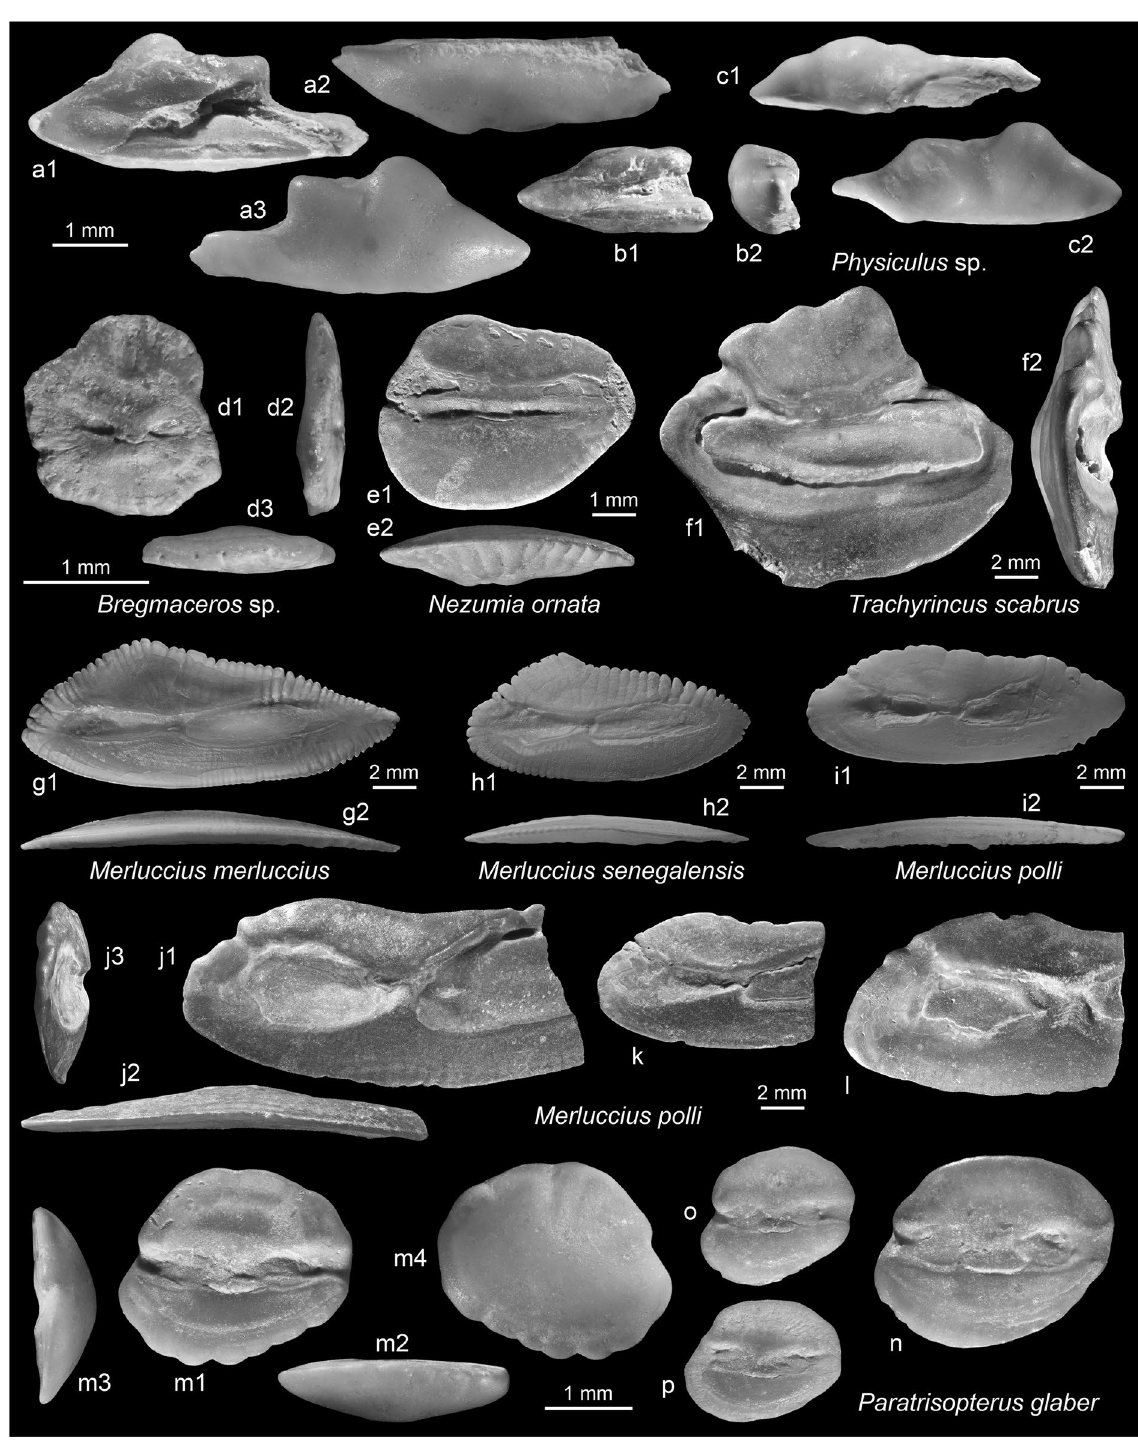
Fig. 14 Gadiformes. a – c Physiculus sp. SMF PO 101.205, Dar bel Hamri. d , Bregmaceros sp. SMF PO 101.206, Dar bel Hamri. e , Nezumia ornata (Bassoli, 1906), SMF PO 101.207 (reversed), Dar bel Hamri. f , Trachyrincus scabrus (Rafinesque, 1810), SMF PO 101.275, Dar bel Hamri. g , Merluccius merluccius (Linnaeus, 1758), extant (reversed), Marmara Sea, Turkey. h , Merluccius senegalensis Cadenat, 1950, extant (reversed), CAS 235494, 14°14’N, 17°32’W. i , Merluccius polli Cadenat, 1950, extant, CAS 235466, 13°53’N, 17°34’W. j – l , Merluccius polli Cadenat, 1950, SMF PO 101.209 ( l reversed), Dar bel Hamri, Zanclean. m – p , Paratrisopterus glaber Schwarzhans, 2010, SMF PO 210, Dar bel